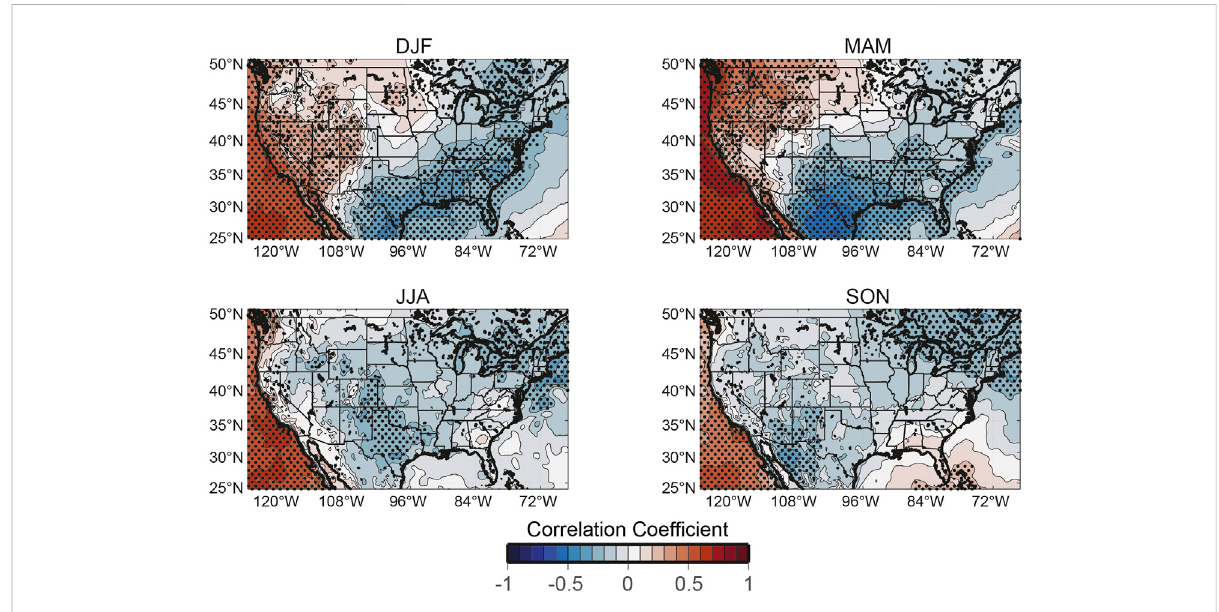
As in Figure 11, but for